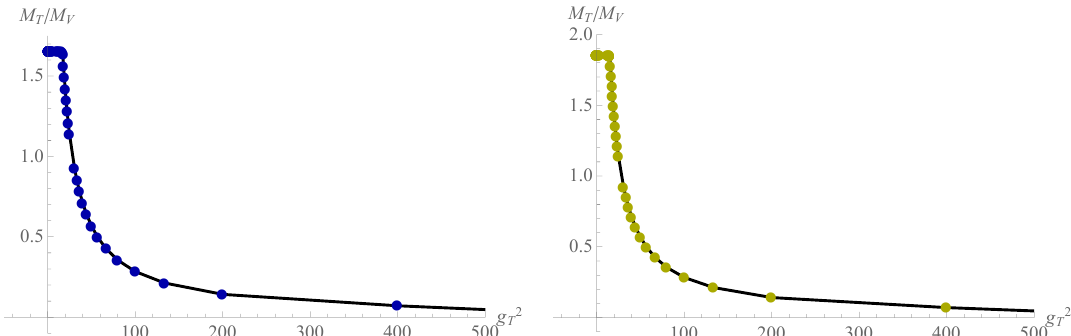
Figure 19. SU(4) 3 F, 3 ¯ F, 5 A 2 — We show the effect of adding the double-trace operator eq. (4.25) to the spin- 1 / 2 baryon’s mass. On the left we use the L 0 ( ρ ) from the F representation and on the right L 0 ( ρ ) from the A 2 representation. Note the initial linear behaviour when g 2 but then as it passes a critical value the effect on the mass is much